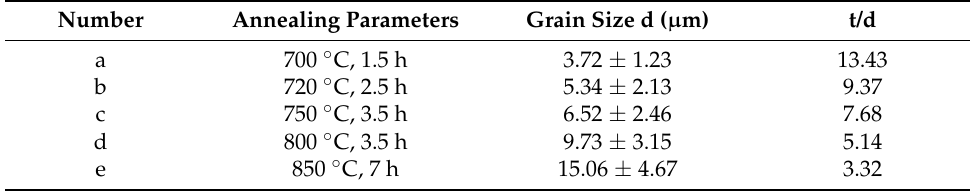
Table 1. Annealing parameters of Ti-2.5Al-1.5Mn